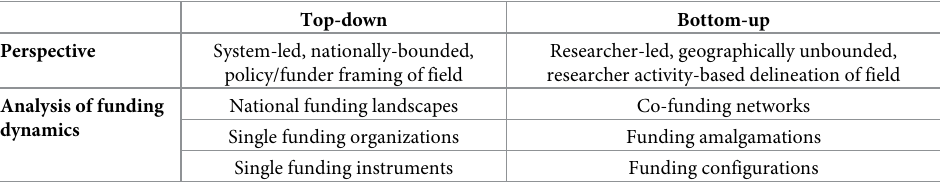
Table 1. Contrasting top-down and bottom-up approaches to research funding. Top-down